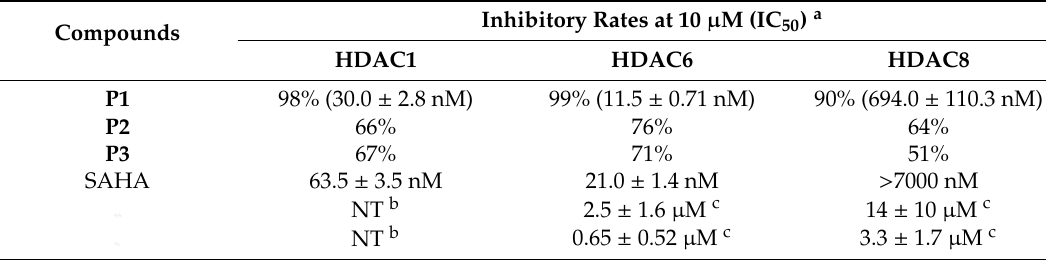
Table 1. HDAC1 / 6 / 8 inhibitory activities of compounds P1 , P2 , P3 and